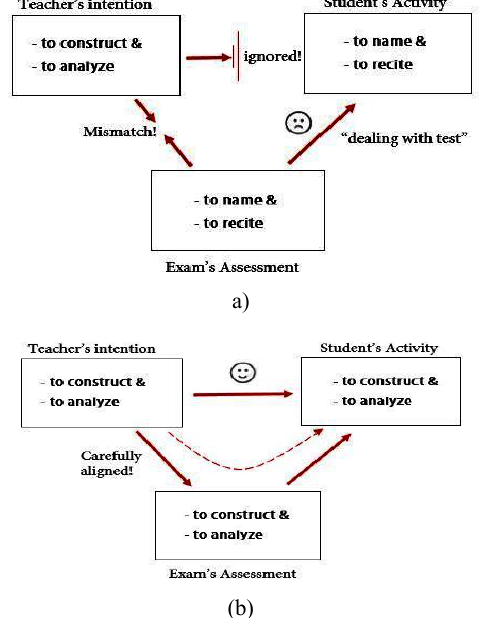
Fig. 1. A description of a) an aligned course b) an unaligned